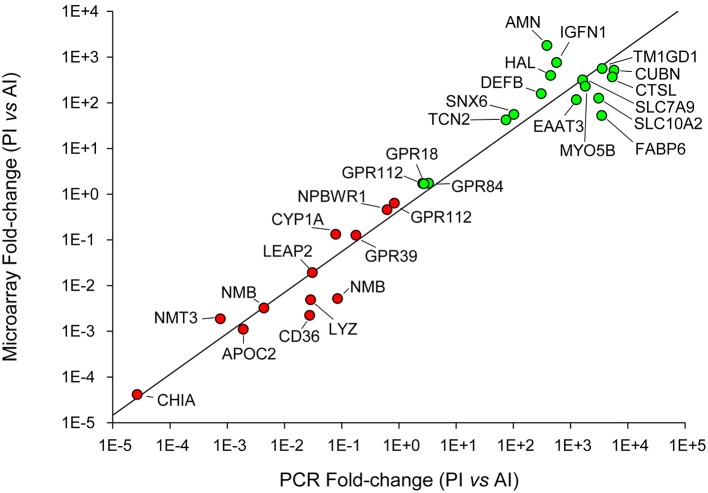
qPCR validation of microarray results. Correlation plot of fold-change (posterior/anterior) values for the selected genes analyzed by qPCR (X-axis) and microarray (Y-axis).